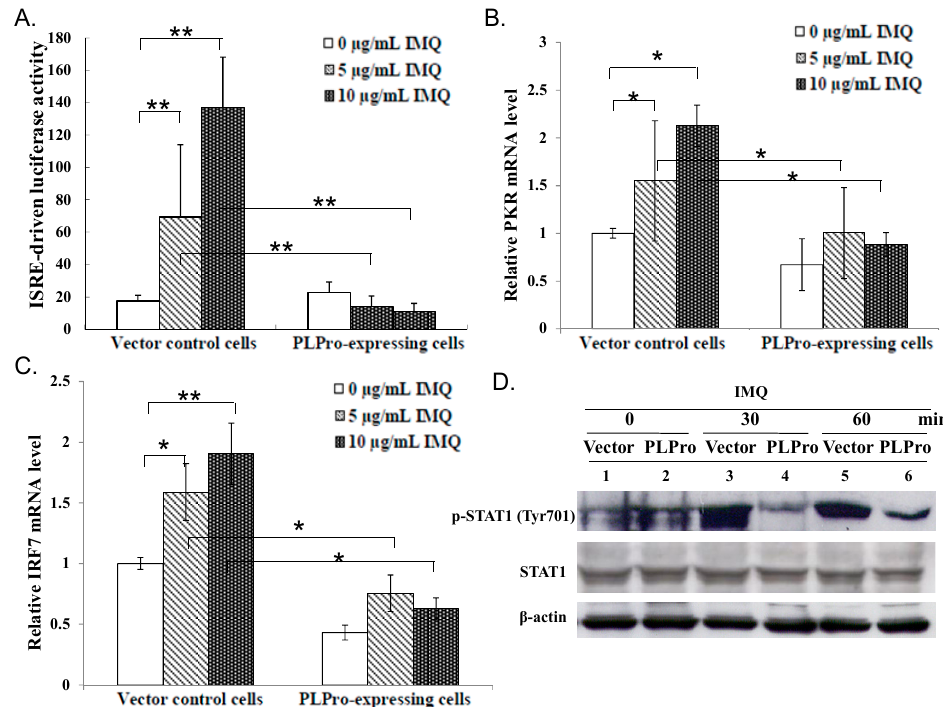
Figure 2. Inhibitory effect of SARS-CoV PLPro on TLR7 agonist-induced activation of type I IFN signaling. ISRE-driven luciferase reporter activity and the mRNA levels of PKR and IRF7 were determined 4 h post-IMQ treatment. ISRE-driven firefly luciferase activity was normalized by Renilla luciferase activity ( A ). Relative mRNA levels of PKR ( B ) and IRF7 ( C ) were normalized by GAPDH mRNA, presented as a relative ratio. In addition, the activated status of STAT1 was examined using Western blot with anti-phospho-STAT1 (Tyr701) antibodies ( D ). * p -Value < 0.05; ** p -value < 0.01 by Student’s t -test.